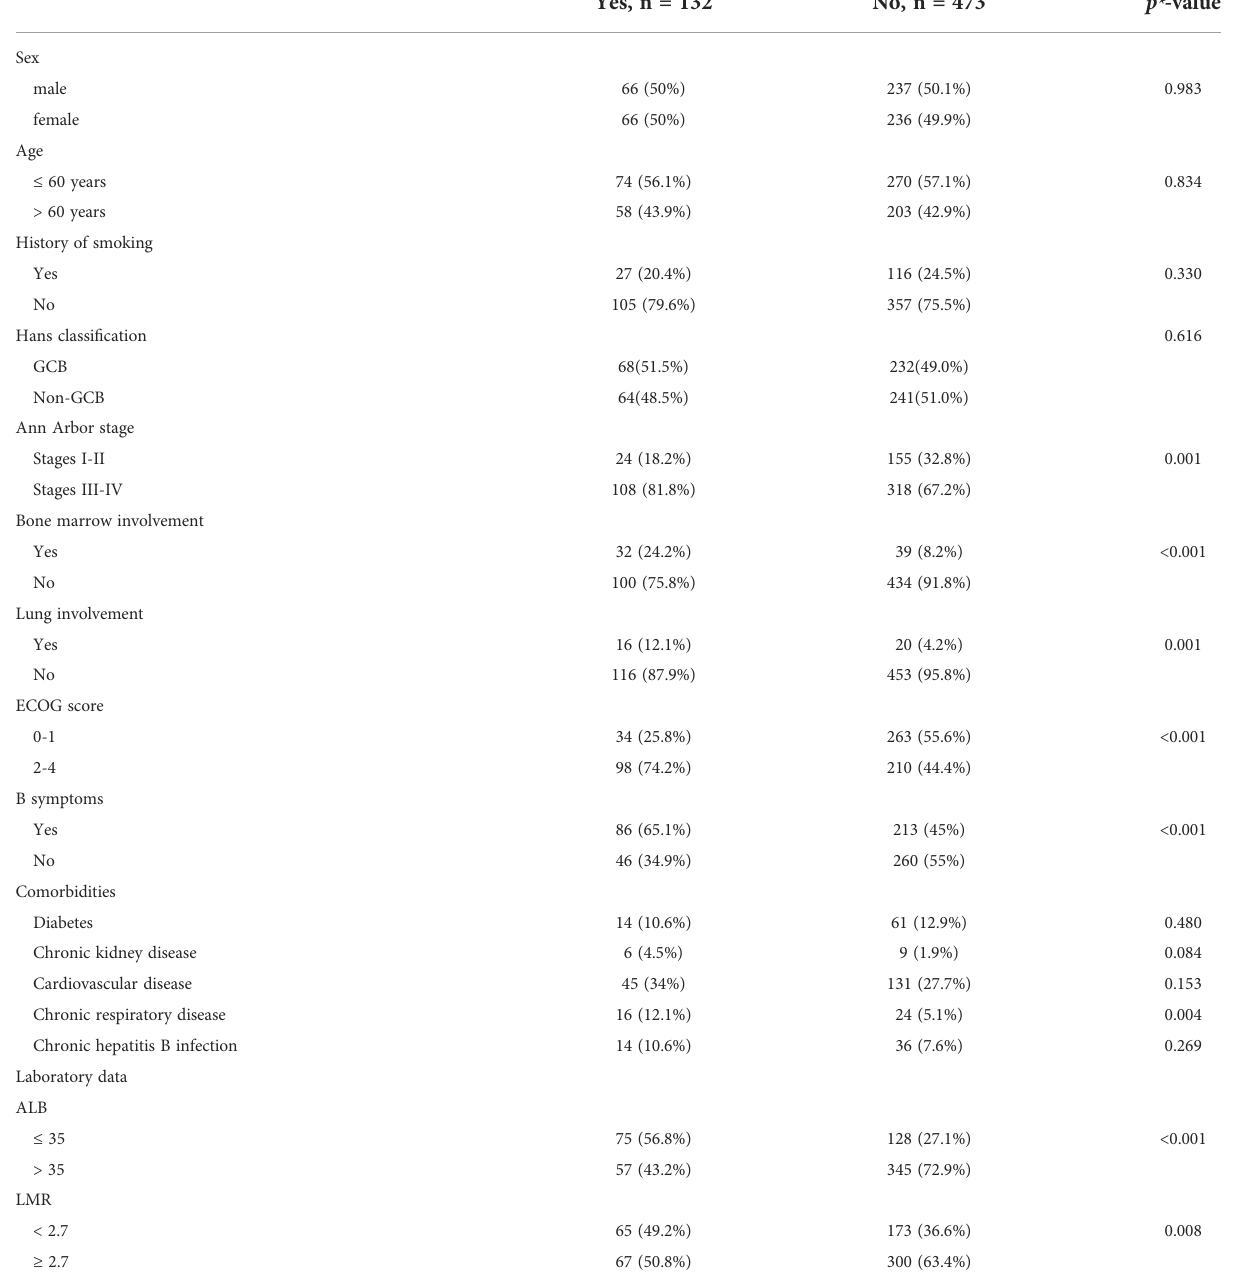
TABLE 1 Clinical characteristics and treatment selection for patients. Clinical characteristic or treatment